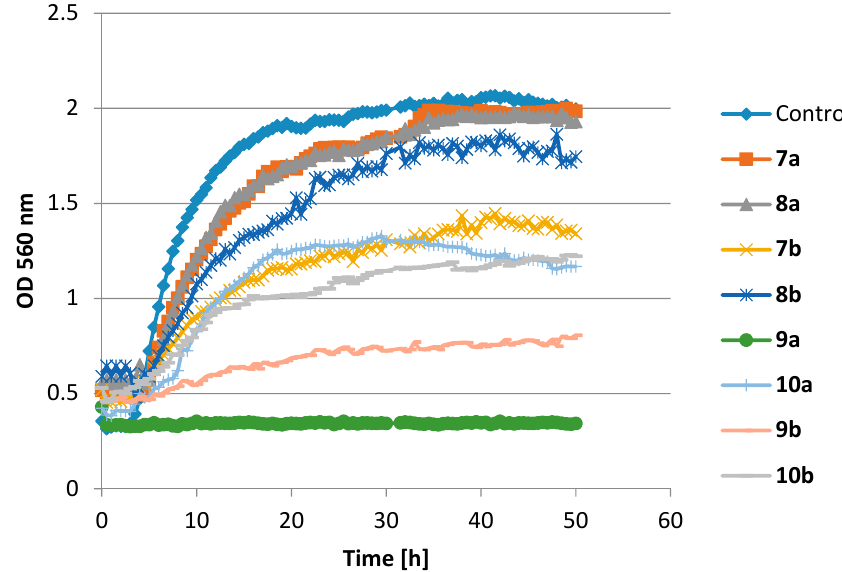
Figure 2. The effect of action of O -alkyl derivatives of naringenin ( 7a – 10a ) and their oximes ( 7b – 10b ) on the growth of S. aureus DSM799.